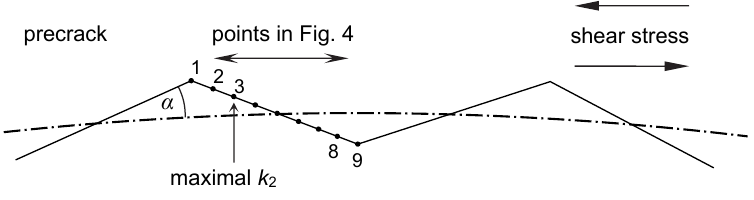
Figure 3: The detail of roughness asperities characterized by the angle α .